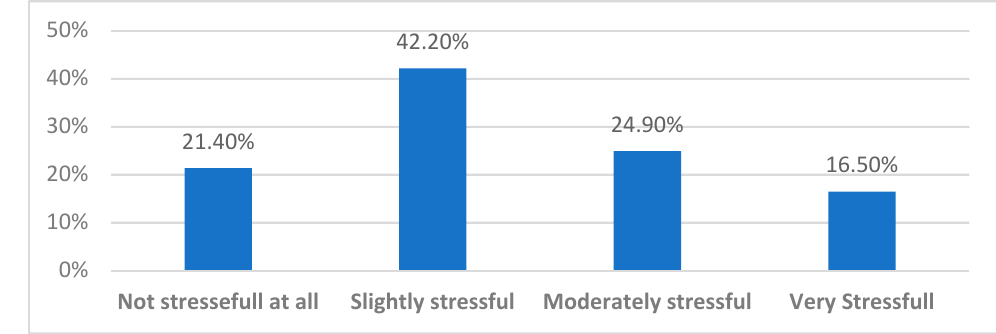
Figure 4. Stress level perceived by the faculty members. Regarding their satisfaction with the virtual interview, video, voice quality, time, and place flexibility all scored higher than 4 out of 5 (Figure 5).